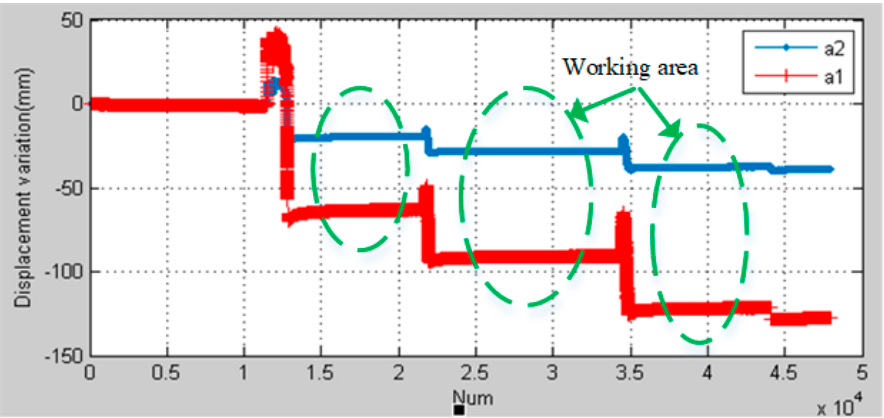
Figure 17. The system of a1 and a2 displacement change diagram. Table 3. Comparison results of wing deformation measurement (mm).